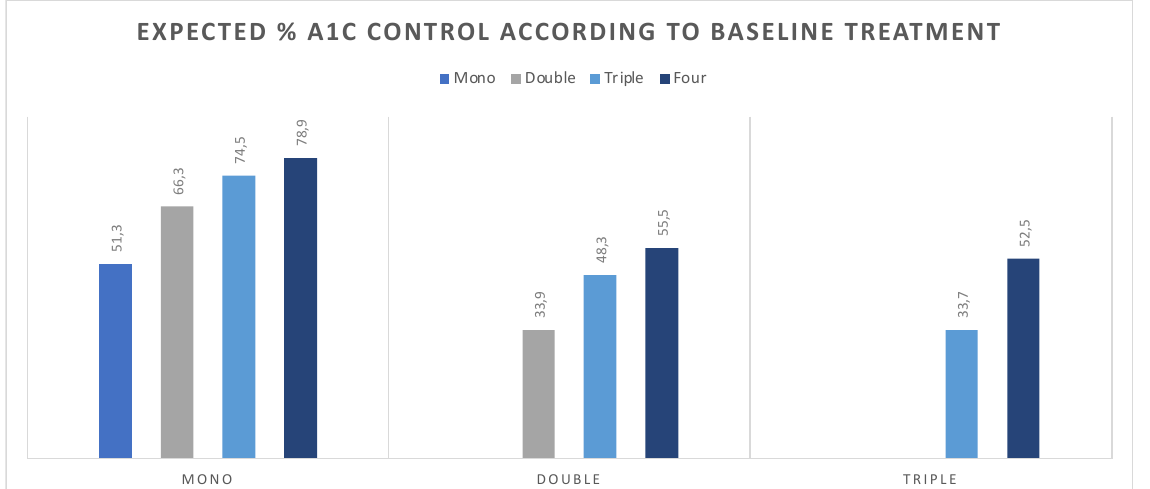
8 of 13 Figure 4. Baseline and expected relative change in SBP control according to current and escalated therapy. AHT, antihypertensive therapy; AHD, antihypertensive drugs; SBP, systolic blood pressure.